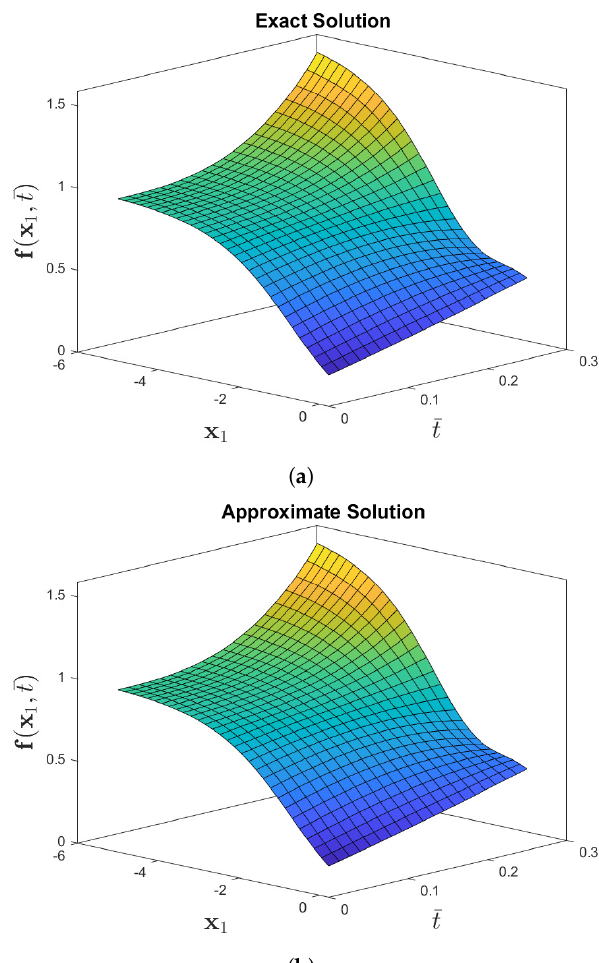
Figure 4. Numerical-behavior of exact and approximate solution to the f ( x 1 , ¯ t ) for Problem 2 when the parameters are θ = 6, β = 1, and ϕ =